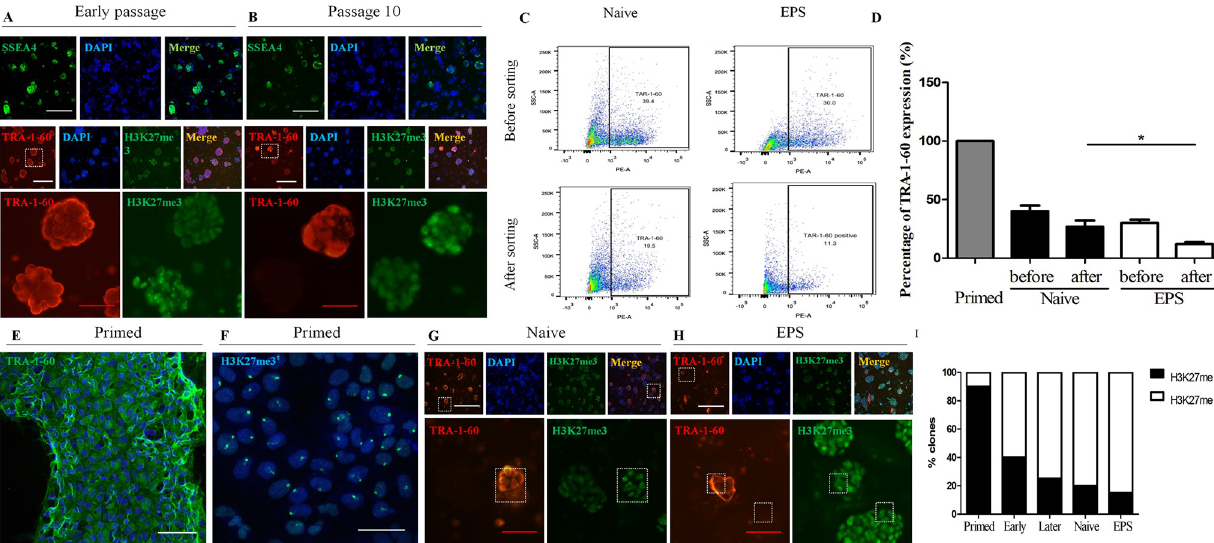
Fig 2. X-chromosome activation state indicated by SSEA4, TRA-1-60 and H3K27me3 expression. (A) Immunostaining of early passage cells for SSEA4, TRA-1-60, and H3K27me3. (B) Immunostaining of late passage cells for SSEA4, TRA-1-60, and H3K27me3. Reverted naive hPSCs display trends of reduced SSEA4 and TRA-1-60 expression with prolonged culture time. (C) The TRA-1-60 ratio of naive hPSCs and EPS cells before and after TRA-1-60 + sorting by FACS. (D) The bar chart shows the TRA-1-60 expression percentages of primed, naive and EPS cells, and the ratio was different between naive and EPS cells after sorting ( P < 0.05). (E) TRA-1-60 expression in primed cells. (F) H3K27me3 expression in primed cells. (G) TRA-1-60 and H3K27me3 expression in naive hPSCs. (H) TRA-1-60 and H3K27me3 expression in EPS cells. (I) The bar chart shows the H3K27me3-positive clone percentages of primed, naive and EPS cells. Magnified images show the staining results of dotted line marks area of low power images. Scale bars = 100 μ m (F: Scale bars = 50 μ m).